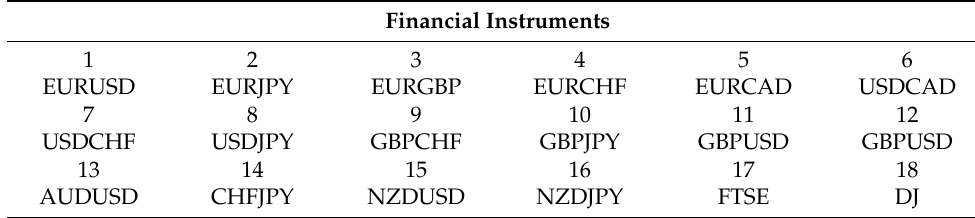
Table 1. Financial instruments and their respective